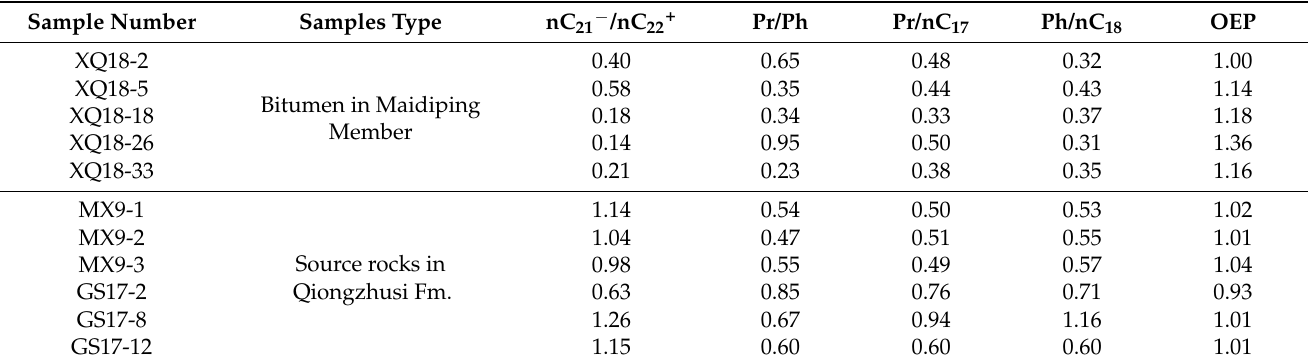
Table 1. The chromatographic parameters of the saturated hydrocarbons in source rocks and reservoir bitumen.